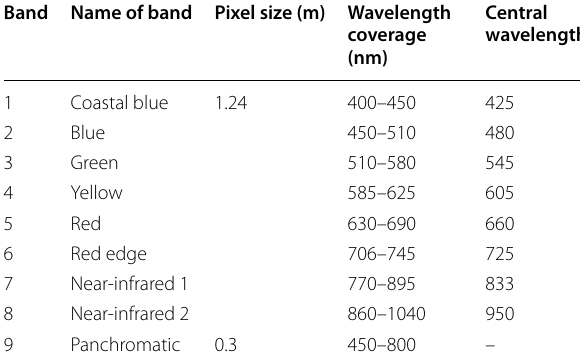
Table 1 Panchromatic and multi-spectral band spatial resolution and wavelength parameters of WorldView-3 imagery